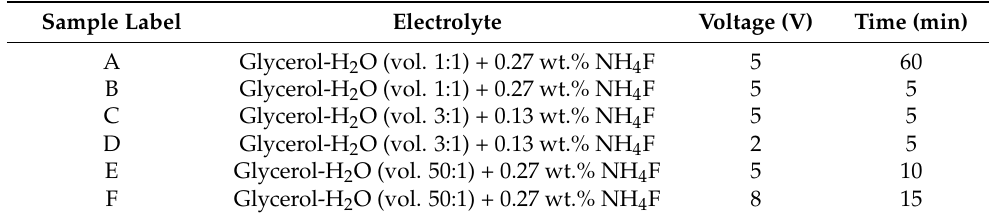
Table 1. Experimental conditions applied for electrochemical reduction of anodized TiO 2 nanotubes. Sample